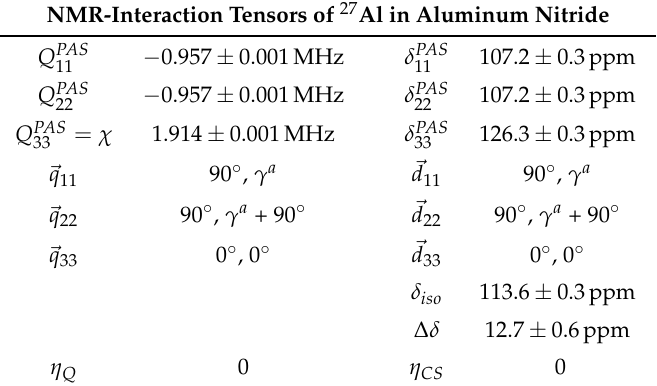
Table 1. Quadrupole coupling tensor Q Al (left), and chemical shift tensor δ Al (right) of 27 Al in the wurtzite structure of AlN, as determined from single-crystal NMR experiments. The orientation of the corresponding eigenvectors are listed in spherical coordinates ( θ , ϕ ) in the hexagonal abc crystal frame CRY . The errors of the experimental values reflect those delivered by the fitting